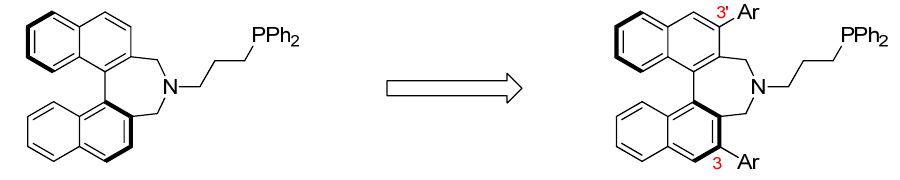
-symmetric element in the 2